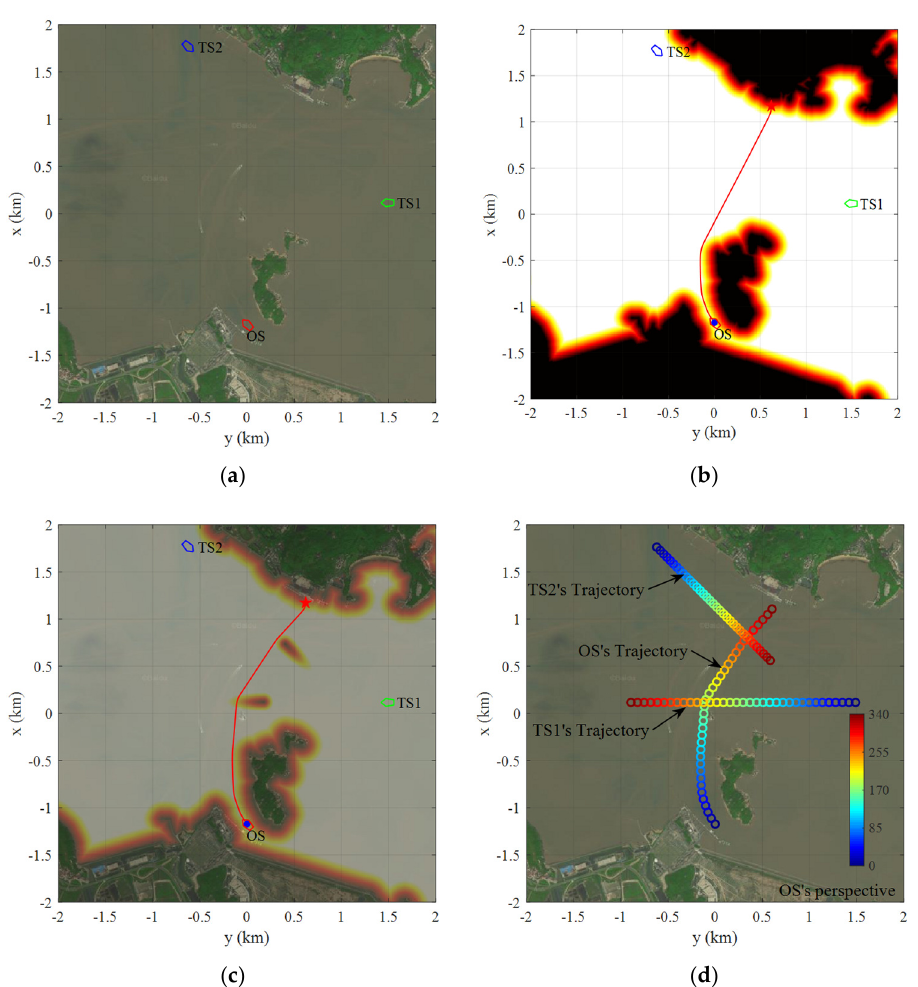
Figure 11. The path planning results and the collision avoidance trajectories in the complex scenario. ( a ) The encounter scenario, ( b ) The preliminary path, ( c ) The path planning results, ( d ) The collision avoidance